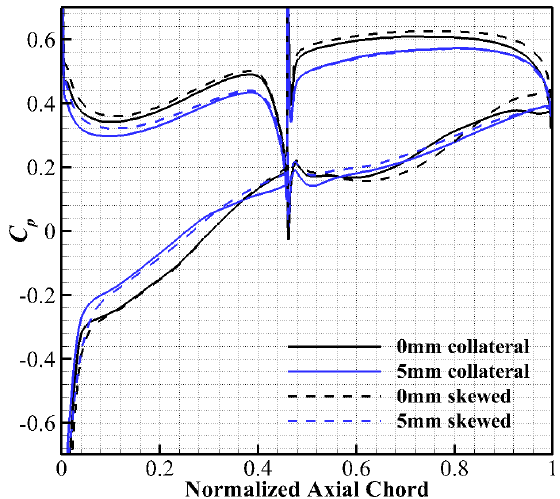
Figure 18. The streamlines and Mach number contours of the tandem cascade at 5% h under different IBL conditions: ( a ) 0 mm collateral; ( b ) 5 mm collateral; ( c ) 0 mm skewed; ( d ) 5 mm skewed.